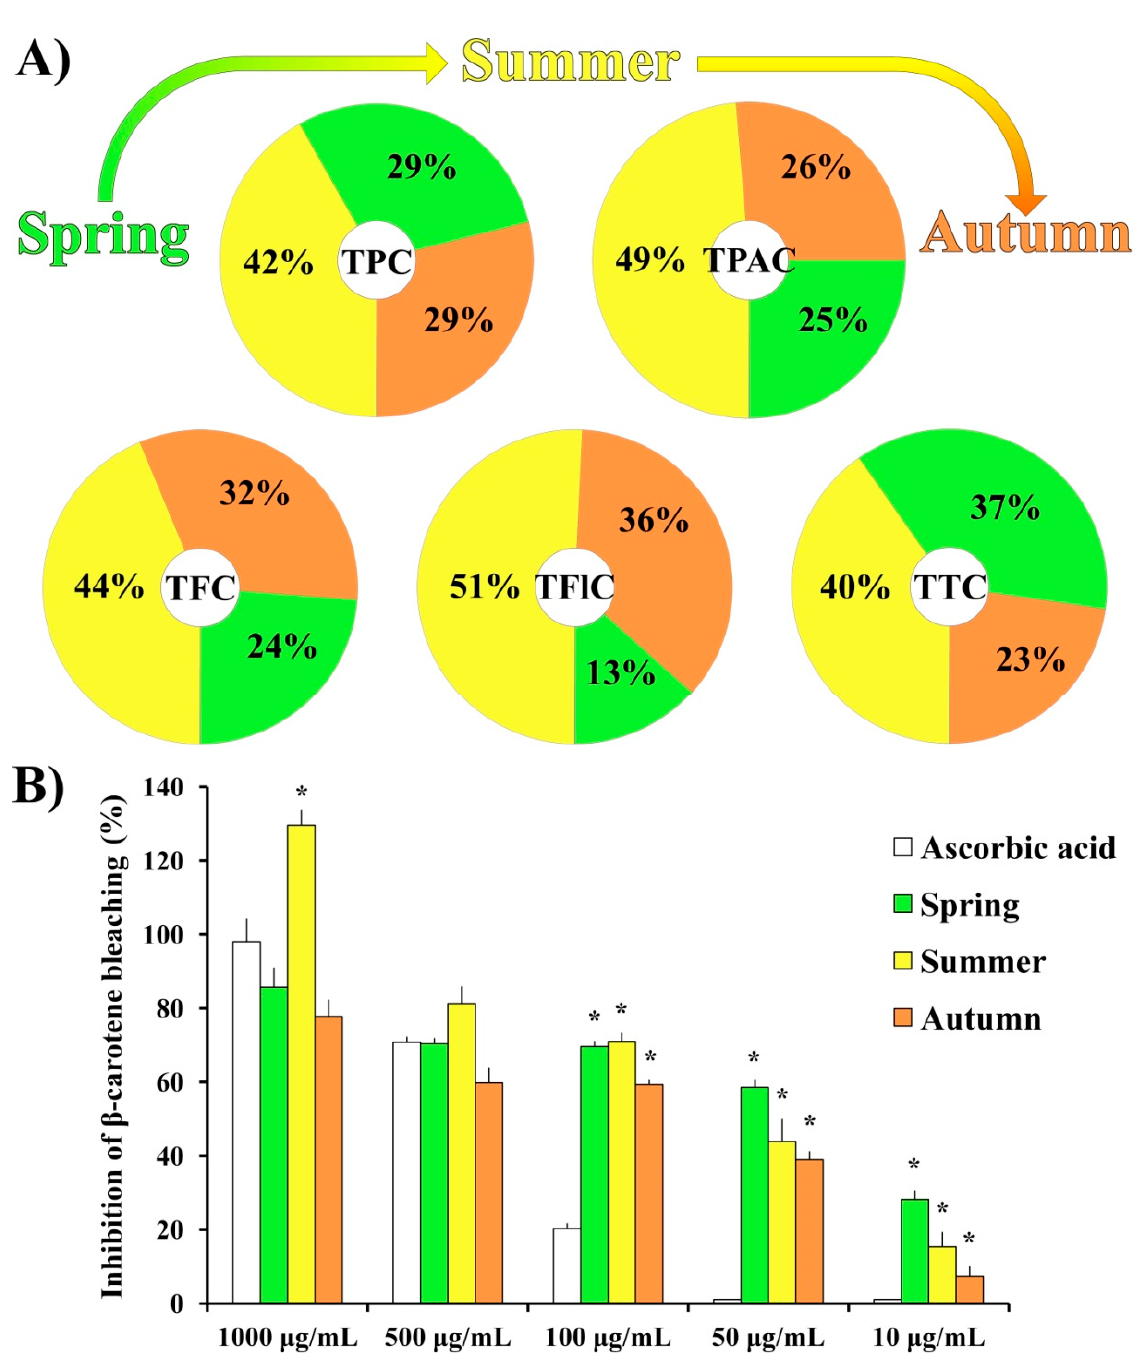
Figure 1. ( A ) Chemical composition and ( B ) antioxidant activity of H. cupressiforme ethyl acetate extracts from different seasonal aspects (spring, summer, and autumn). The results are presented as the mean ± standard error (* p < 0.05 different seasons vs. standard substance ascorbic acid).